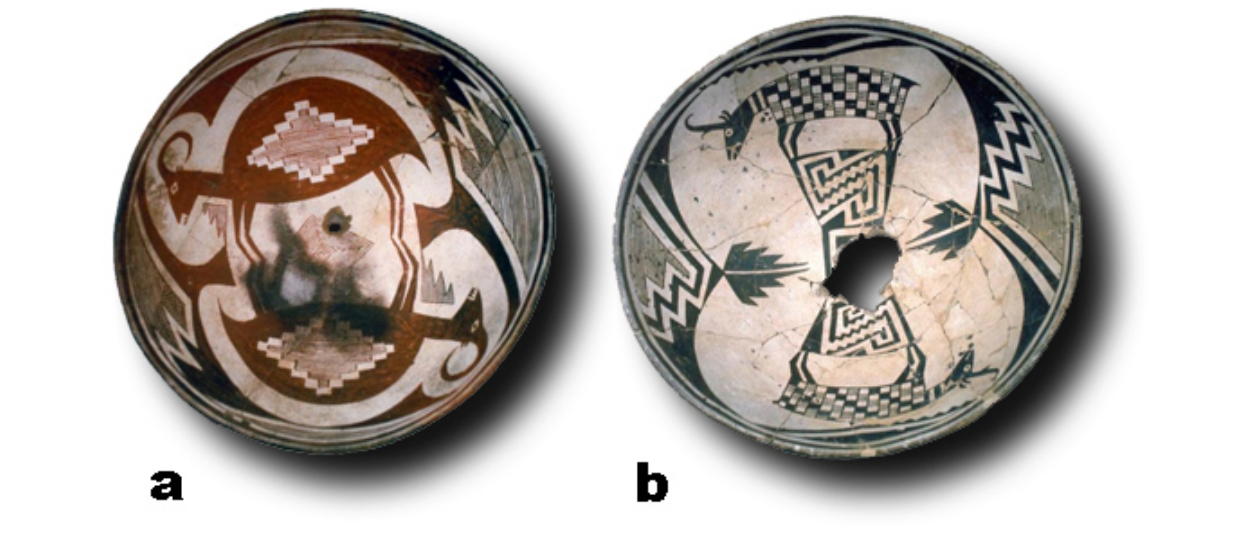
Fig. 5 . Similarly structured Mimbres black-on-white bowls featuring representations of a) bighorn sheep, and b) pronghorn antelope. Images courtesy of the Peabody Museum of Archaeology and Ethnology, Harvard